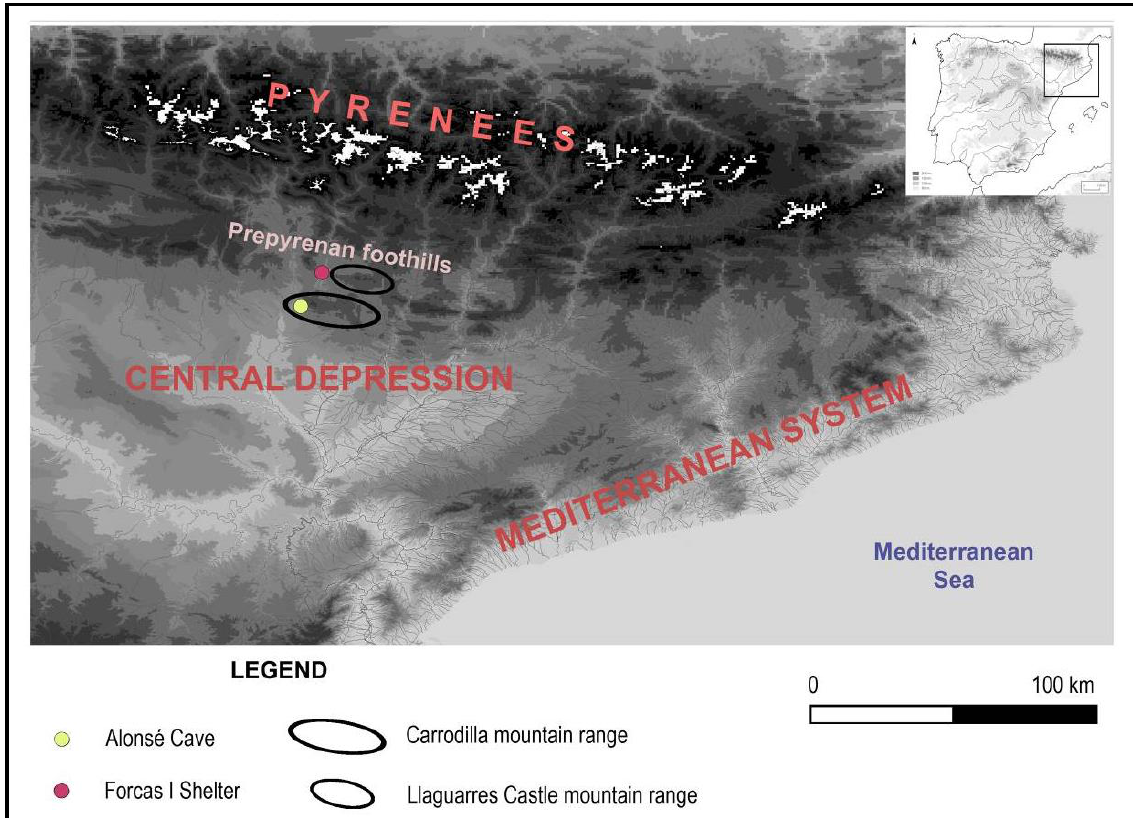
Figure 1. Study area with the main geographical units of the region and the location of the two archaeological